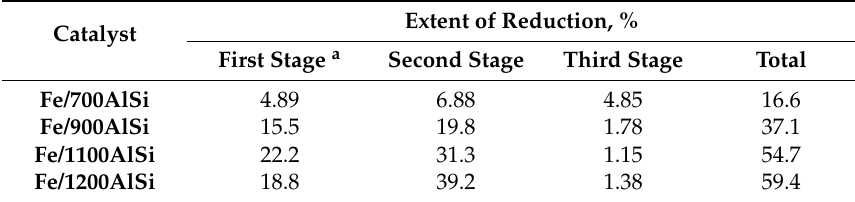
Figure 3. H 2 -TPR profiles of Fe catalysts supported on supports calcined at different temperatures. Table 3. Extent of reduction (EOR) from temperature programmed reduction (TPR) weight loss.